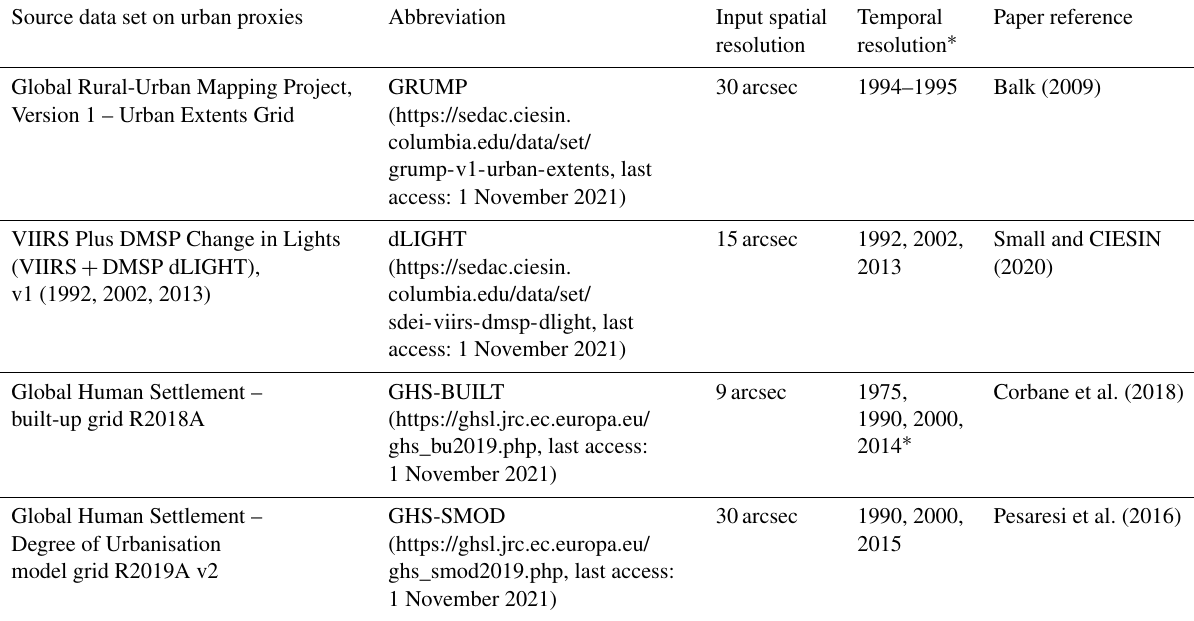
Table 3. Urban-proxy data sets used to estimate persons living in the low-elevation coastal zones (LECZs). Source data set on urban